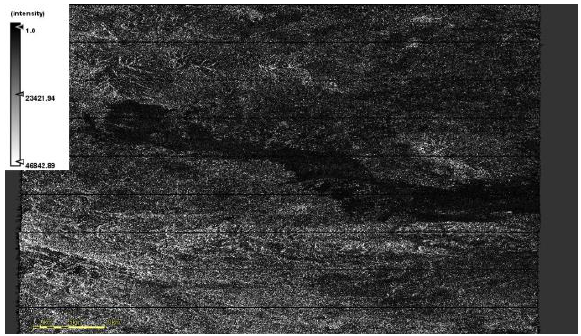
Figure 3. Map of Intensity